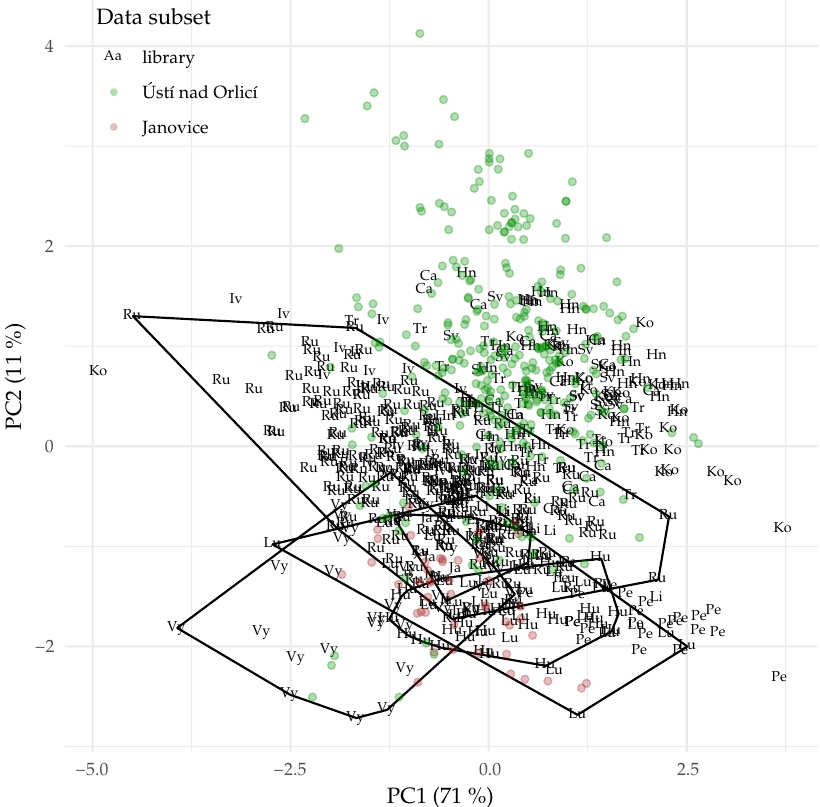
Figure 5. Projection of the principal component space derived from MIR-DRIFTS spectra after basic pre-processing. Convex hulls of the library sites similar to Janovice are displayed. The smallest, central polygon represents Jaromˇeˇrice. Ca— ˇCáslav, Hn—Hnˇevˇceves, Hu—Humpolec, Iv—Ivanovice na Hané, Ja—Jaromˇeˇrice, Ko—Kostelec nad Orlicí, Li—Lípa, Lu—Lukavec, Pe—Pernolec, Ru—Praha-